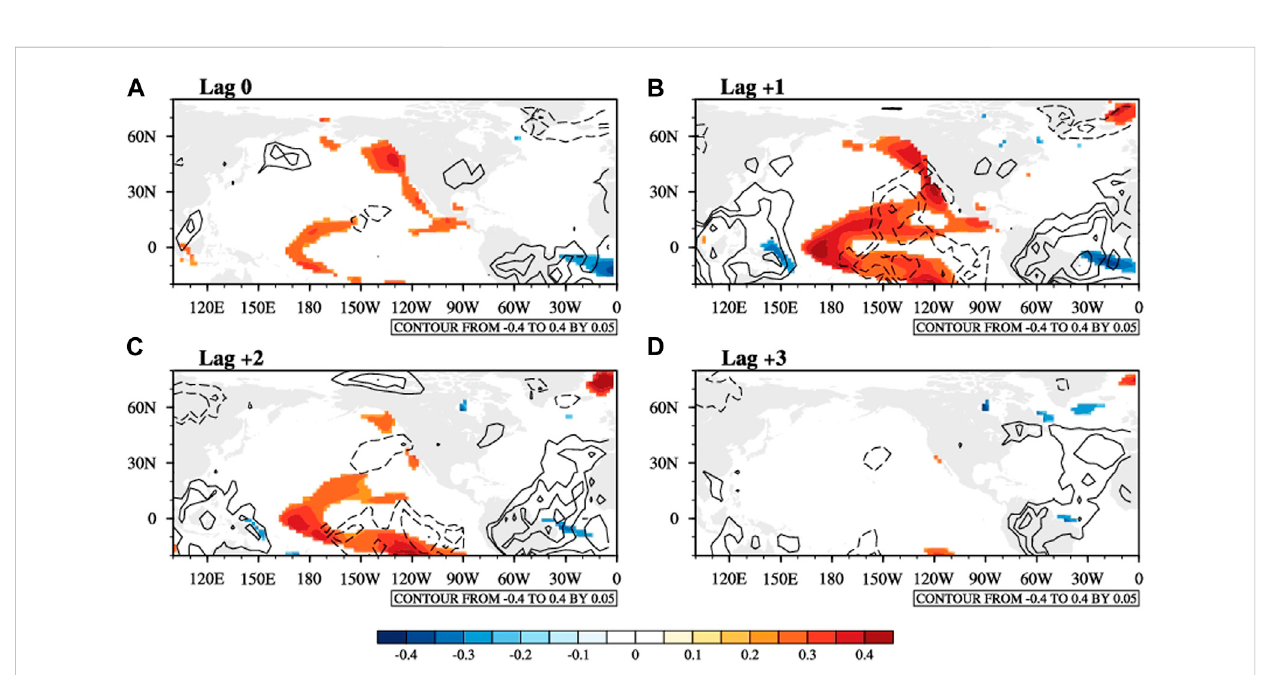
FIGURE 1 (A – D) Lagged correlation maps of observed DJF-mean F10.7 index with the observed DJF-mean SLP (contours) and JJA-mean SST (color shading contours) anomalies (1950 – 2018) at a lag of 0 – 3 years. The contour interval is 0.05 and only the values above the 90% con fi dence level are